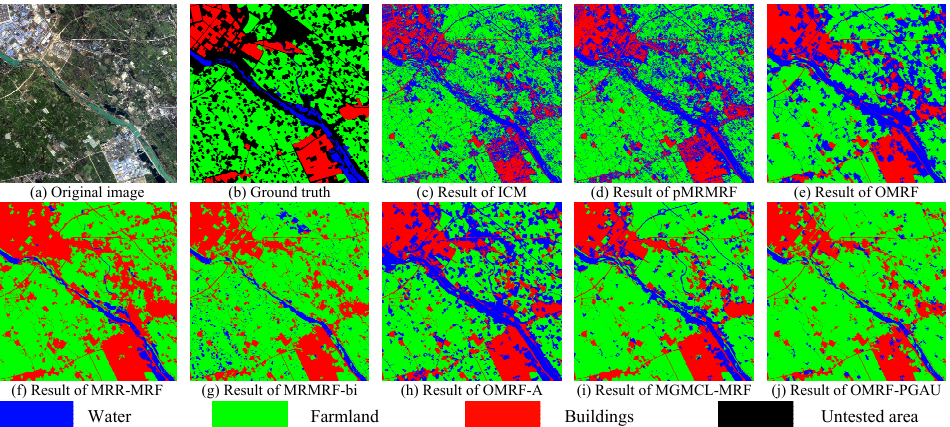
Figure 14. Semantic segmentation results for big size Gaofen-2